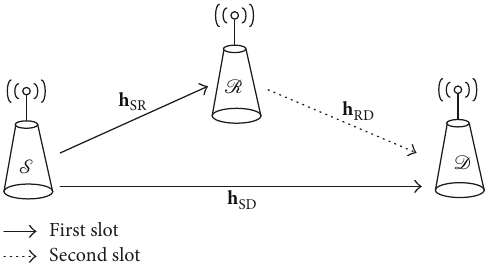
Figure 1: Network Model of AF Relay in three-node mode. subcarriers but results in the interference of cooperative